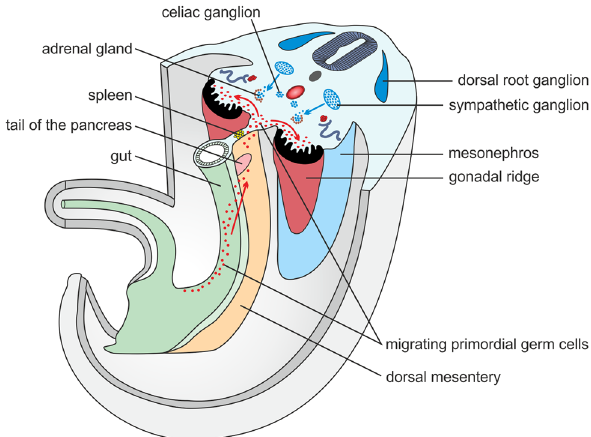
Figure 3: A scheme showing a transsection of an embryo during the fi fth week of embryonic age. Note the primordial germ cells migrating along the dorsal mesentery into the retroperitoneum in close proximity to the developing spleen.